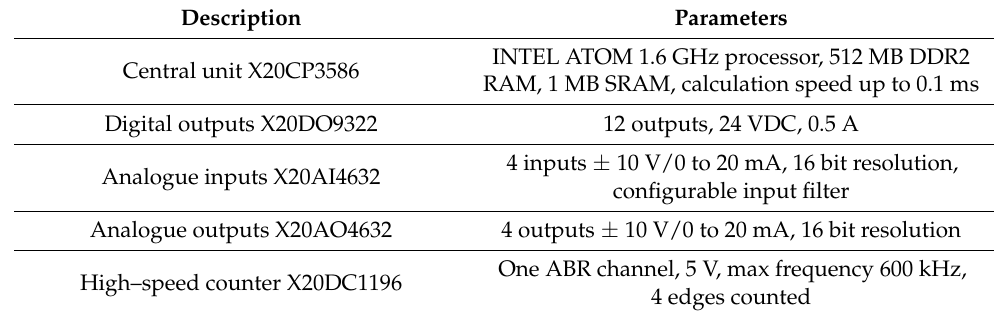
Table 1. Parameters of the PLC